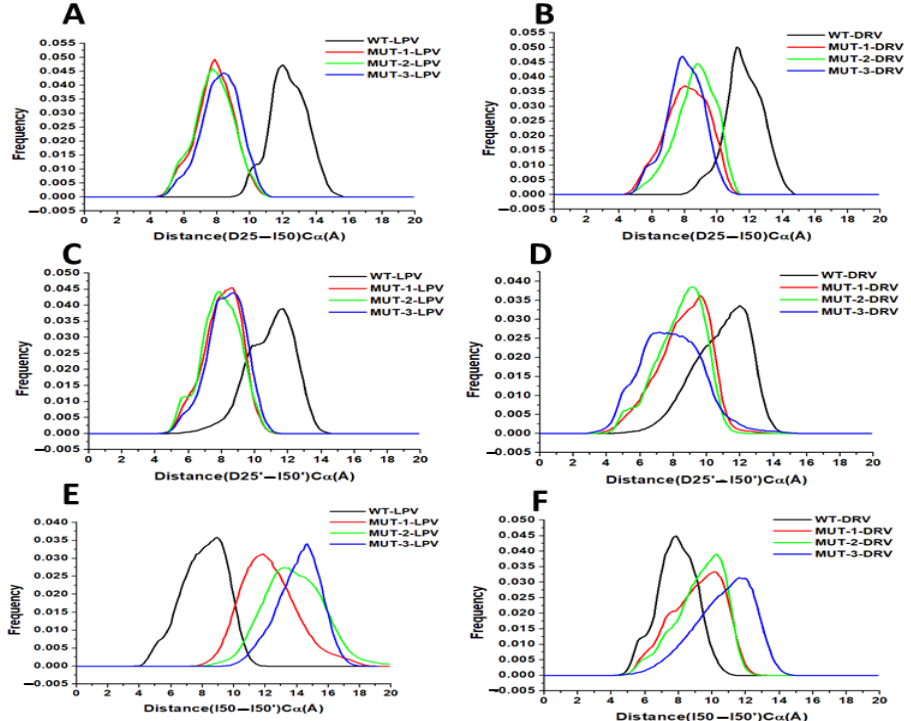
Figure 8. ( A ) Histogram distribution of D25-I50 distance for WT and mutant HIV-1 PR variants interaction with LPV. ( B ) Histogram distribution of D25-I50 distance for WT and mutant HIV-1 PR variants interaction with DRV. ( C ) Histogram distribution of D25 (cid:48) -I50 (cid:48) distance for WT and mutant HIV-1 PR variants interaction with LPV. ( D ) Histogram distribution of D25 (cid:48) -I50 (cid:48) distance for WT and mutant HIV-1 PR variants interaction with DRV. ( E ) Histogram distribution of I50-I50 (cid:48) distance for WT and mutant HIV-1 PR variants interaction with LPV. ( F ) Histogram distribution of I50-I50 (cid:48) distance for WT and mutant HIV-1 PR variants interaction with